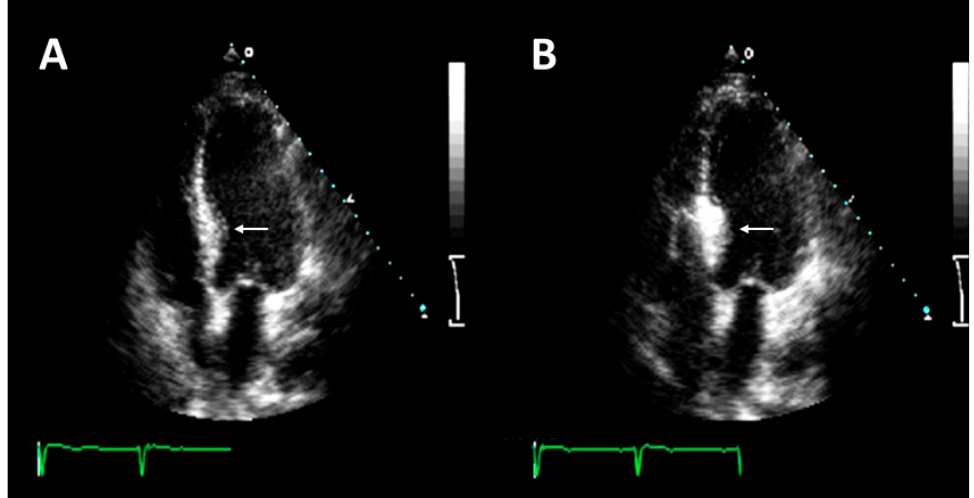
Figure 2. Echocardiographic contrast used for the guidance of alcohol septal. ( A ) Four-chamber echocardiogram shows increased LV wall thickness at basal septum level with no apical aneurysm (arrow). ( B ) Intracoronary echocardiographic contrast injection is localized to the basal septum at the site of greatest hypertrophy (arrow) without extending beyond the point of mitral septal contact, consistent with an appropriate target vessel for alcohol septal ablation.